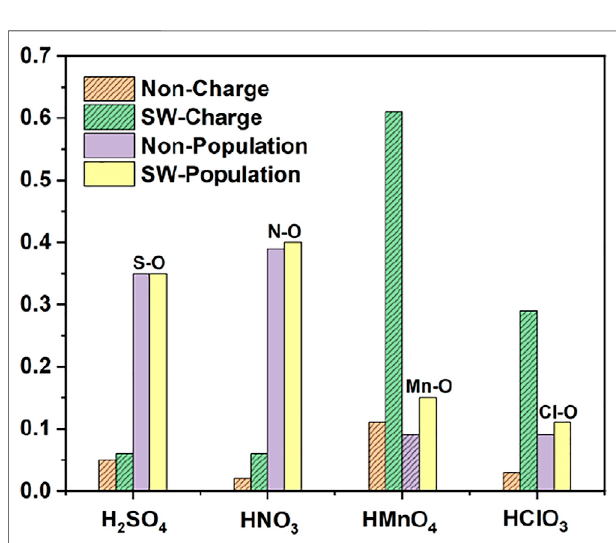
FIGURE 3 | Charge and bond population of single-component acid molecules reacting with the non-defect and Stone-Wales defect graphene in the absence of water. The shadow indicates that this value is